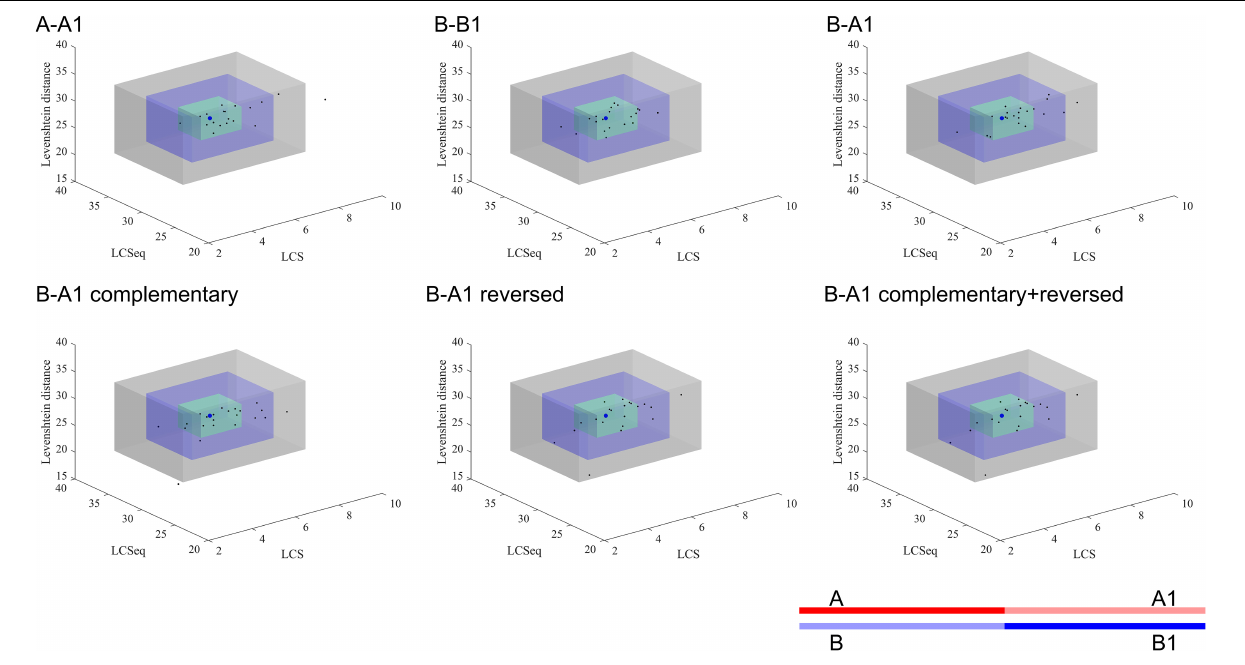
FIGURE 4 | Similarity analyses of subsequences near the breakpoints. The blue dot represents the mean value of the random sequences and each black dot presents the index data of a patient. The green, blue, and gray cuboid indicates 1, 2, and 3 standard deviations from the mean value, respectively. A, A1, B, and B1 represent different segments of the corresponding gene sequences as the legend shows. A: upstream 50 bp of start point; A1: downstream 50 bp of start point of reference sequence; B: upstream 50 bp of end point of reference sequence; B1: downstream 50 bp of end point. The semitransparent lines show the deleted